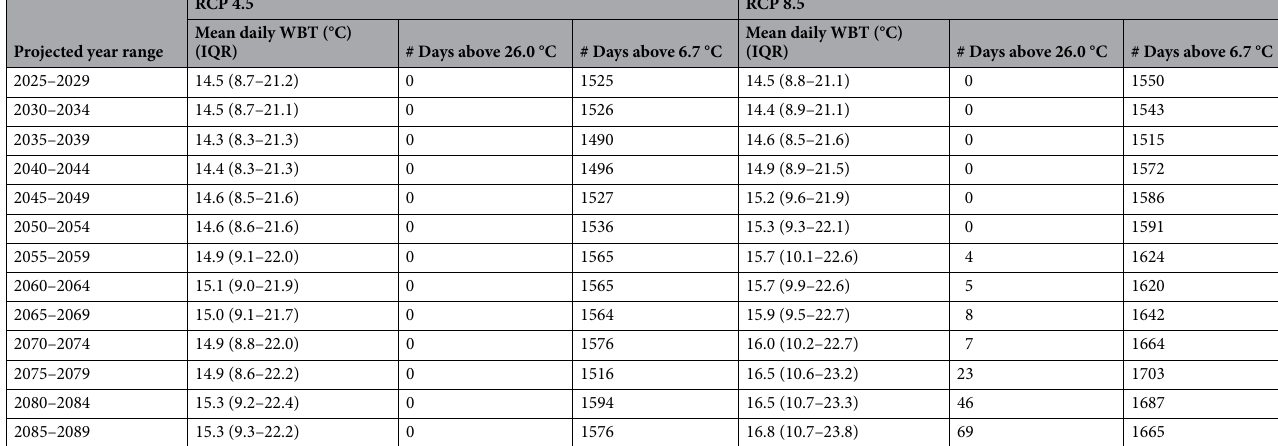
Table 2. Projected mean WBT and days exceeding historic maximum (26.0 °C) and the referent temperature (6.7 °C) in each projected 5-year period.